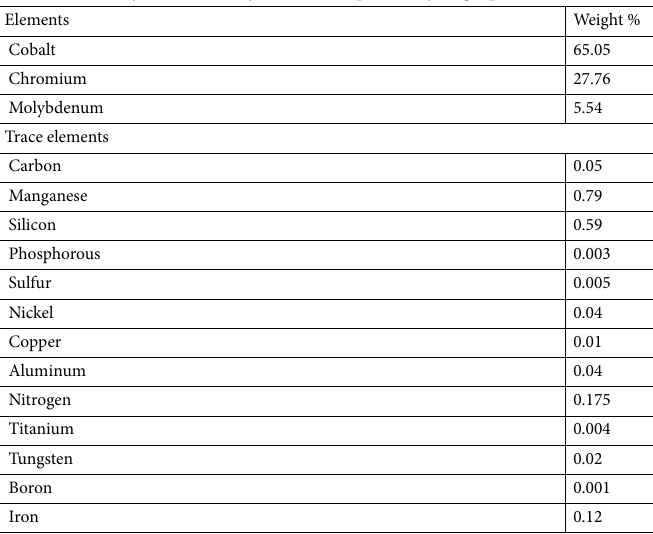
Table 1. Elemental analysis of CoCrMo metal alloy used in testing provided by United Performance Metals. Report completed by Carpenter Technology Corporation at time of purchase 31